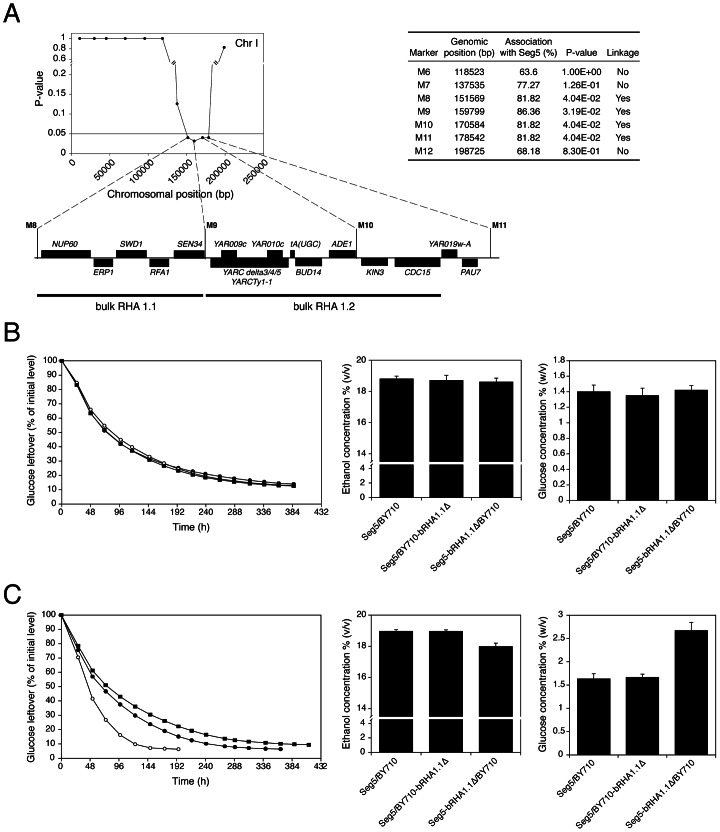
Fine-mapping and bulk RHA of QTL2.(A) Genes present in QTL2 (pool 1), located on chromosome I, as determined by markers scored in the 22 segregants individually. (B) Bulk RHA (bRHA 1.1) of genes NUP60, ERP1, SWD1, RFA1 and SEN34. Two heterozygous diploids for the five genes were constructed: Seg5/BY710-bRHA1.1Δ (○) and Seg5-bRHA1.1Δ/BY710 (▪). These two diploids were compared with the original strain Seg5/BY710 (•) in semi-static fermentations performed in 250 mL of YP+33% glucose at 25°C. (C) Bulk RHA (bRHA 1.2) of genes YARCdelta3/4/5, YARCTy1-1, YAR009c, YAR010c, tA(UGC), BUD14, ADE1, KIN3, and CDC15. Two heterozygous diploids for the previous genes were constructed: Seg5/BY710-bRHA1.2Δ (○) and Seg5-bRHA1.2Δ/BY710 (▪). These two diploids were compared with the original strain Seg5/BY710 (•) in semi-static fermentations performed in 250 mL of YP+33% glucose at 25°C.